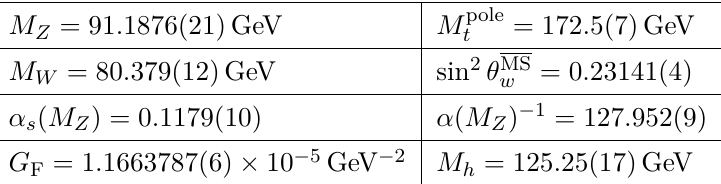
Table 1 . Primary input values used in our numerics; all numbers are taken from the PDG [2].